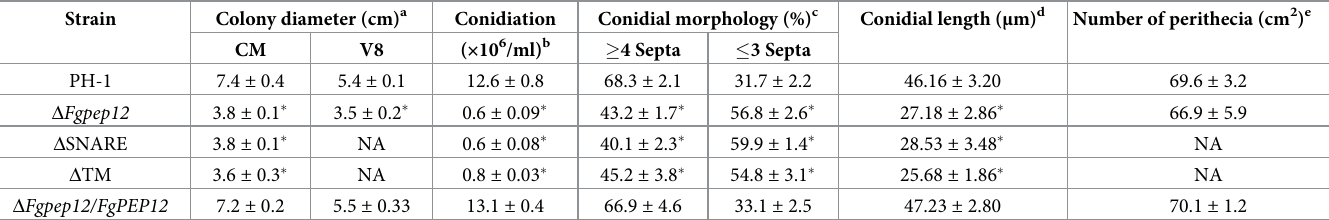
Table 1. Phenotype analysis of the PH-1, Δ Fgpep12 , Δ Fgpep12/FgPEP12 and domain deletion strains.